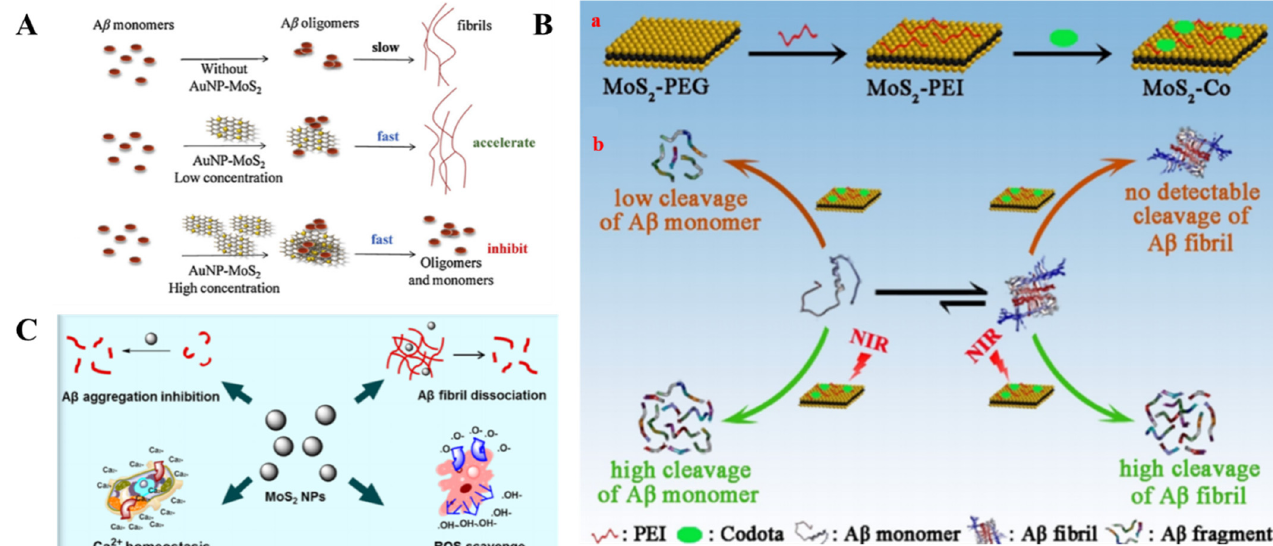
Figure 11. ( A ) Schematic illustration of the mechanism of the concentration-dependent effect of AuNP-MoS 2 nanocomposites on A β 1–40 aggregation. Reprinted with permission from reference [146]. Copyright 2019 Elsvier. ( B ) Schematic illustration of the synthesis route of MoS 2 -Co and hydrolysis enhanced by MoS 2 -Co in the presence of an NIR laser. (a) Synthesis route of MoS 2 -Co. (b) In the presence of NIR laser, MoS 2 -Co not only improves the hydrolytic activity toward Ab monomers (left side) but also enhances the hydrolytic capacity toward Ab fibrils (rightside). Reprinted with permis- sion from reference [152]. Copyright 2019 Wiley-VCH. ( C ) Schematic illustration of MoS 2 NPs as multifunctional inhibi- tors against AD. Reprinted with permission from reference [153]. Copyright 2017 American Chemical Society. MoS 2 NPs are also drawing more and more interest as self-lubricating coatings and in biochemical applications. Han et al. prepared spherical polyvinylpyrroli- done-functionalized MoS 2 NPs with an average diameter of 100 nm using a pulsed laser ablation method and found that they show multifunctional effects on A β 1–42 aggregation (Figure 11C) [153]. MoS 2 NPs could adsorb A β 1–42 monomers or oligomers on the surface based on the interaction between MoS 2 NPs and the hydrophobic region of A β 1–42 . This delays the nucleation process, inhibits A β 1–42 aggregation and destabilizes the preformed fibrils. As a result, the calcium channel induced by the incorporation of A β 1–42 oligomers into neuronal cell membranes was blocked to ensure calcium homeostasis and protect neuronal cells. Moreover, MoS 2 NPs could reduce the intracellular ROS ( . OH) level in- duced by A β 1–42 . 2.4.3. Graphitic Carbon Nitride Unlike bulk g-C 3 N 4 , the 2D ultrathin g-C 3 N 4 nanosheet is the most stable allotrope of carbon nitride under ambient conditions. It has excellent properties of good biocompati- bility, high surface-area-to-volume ratio and nontoxicity and was employed in bioimag- ing, drug delivery and cancer diagnosis. A g-C 3 N 4 nanosheet, with a narrow band gap of 2.7 eV, can act as a stable photo- catalyst for water splitting and the degradation of organic pollutants. Chung et al. ap- plied photoactive g-C 3 N 4 for the light-induced suppression of A β aggregation and tox- icity [154]. As shown in Figure 12A, the photosensitized g-C 3 N 4 generated oxidative ROS through photoinduced electron transfer under visible-light illumination, which further oxidized A β peptides, preventing the aggregation of A β monomers. However, g-C 3 N 4 had no obvious effect on A β aggregation under dark conditions. Moreover, doping tran- sition metal ions could promote ROS generation and enhance their inhibition efficiency. To enhance the photodegradation efficiency, Wang et al. used GO/g-C 3 N 4 as the photo- catalyst for irreversible disassembly of A β 33–42 aggregate into nontoxic monomers under UV (Figure 12B) [155]. In this nanocomposite, GO acts as an A β collector due to its high